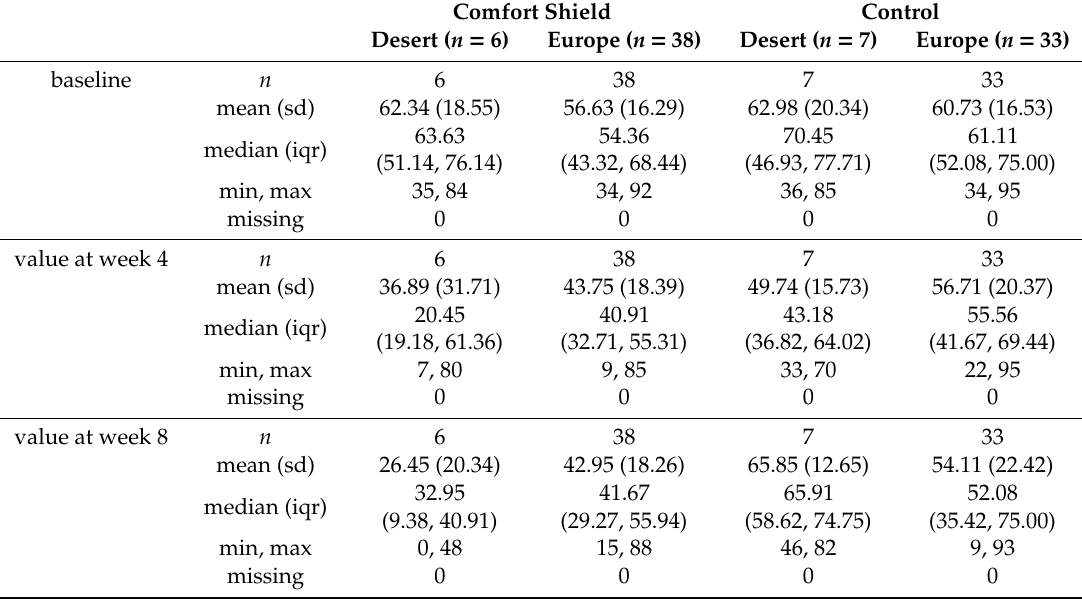
Table A7. OSDI: value at baseline and at each post-baseline visit—PPS ( n = 84)—descriptive analysis by